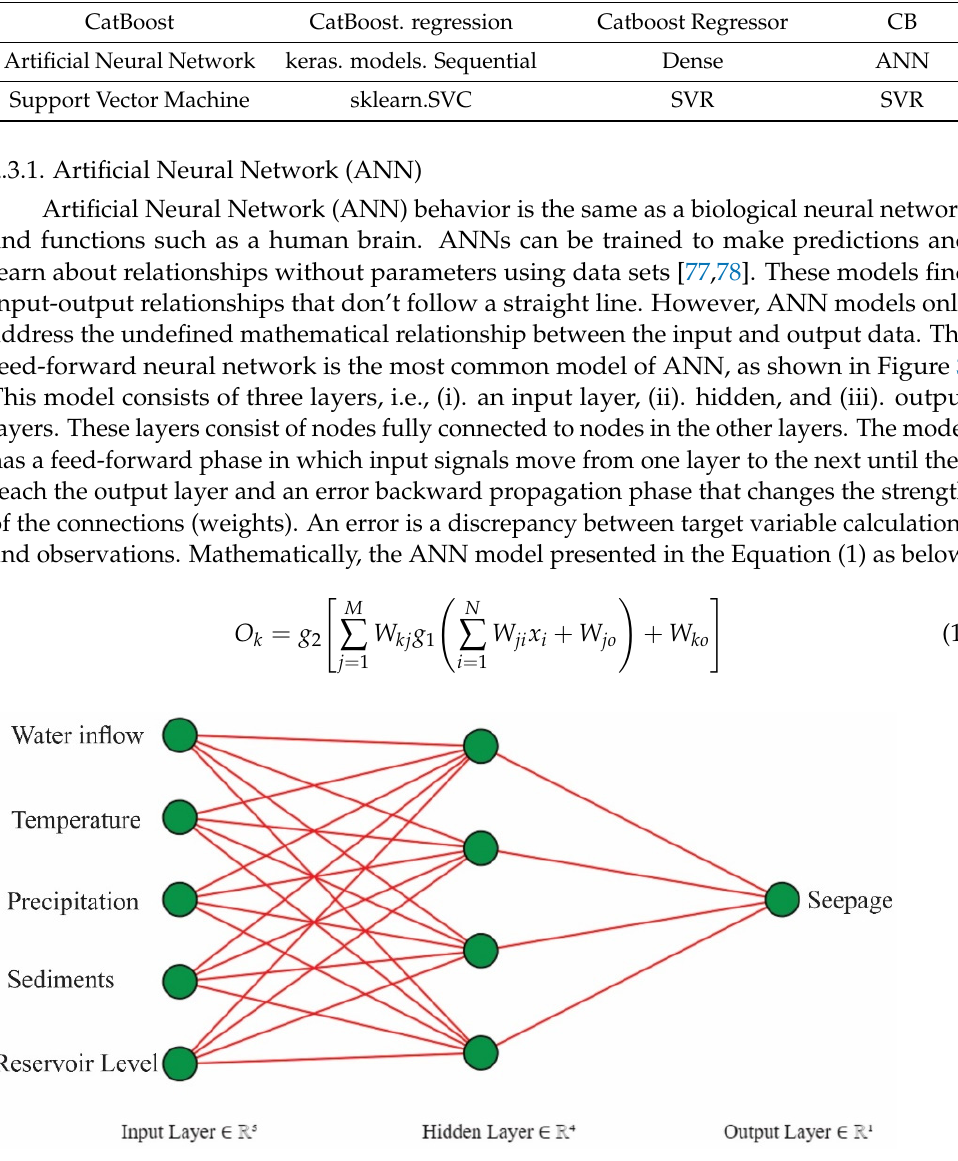
Random Forest sklearn. ensemble Random Forest Regressor RF